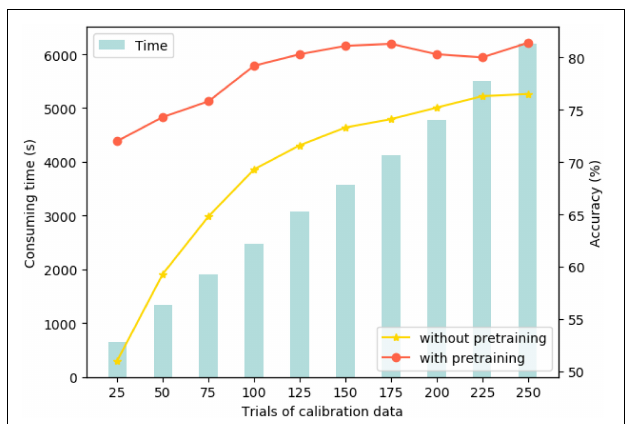
FIGURE 9 | Training accuracy and calibration time in both modes.